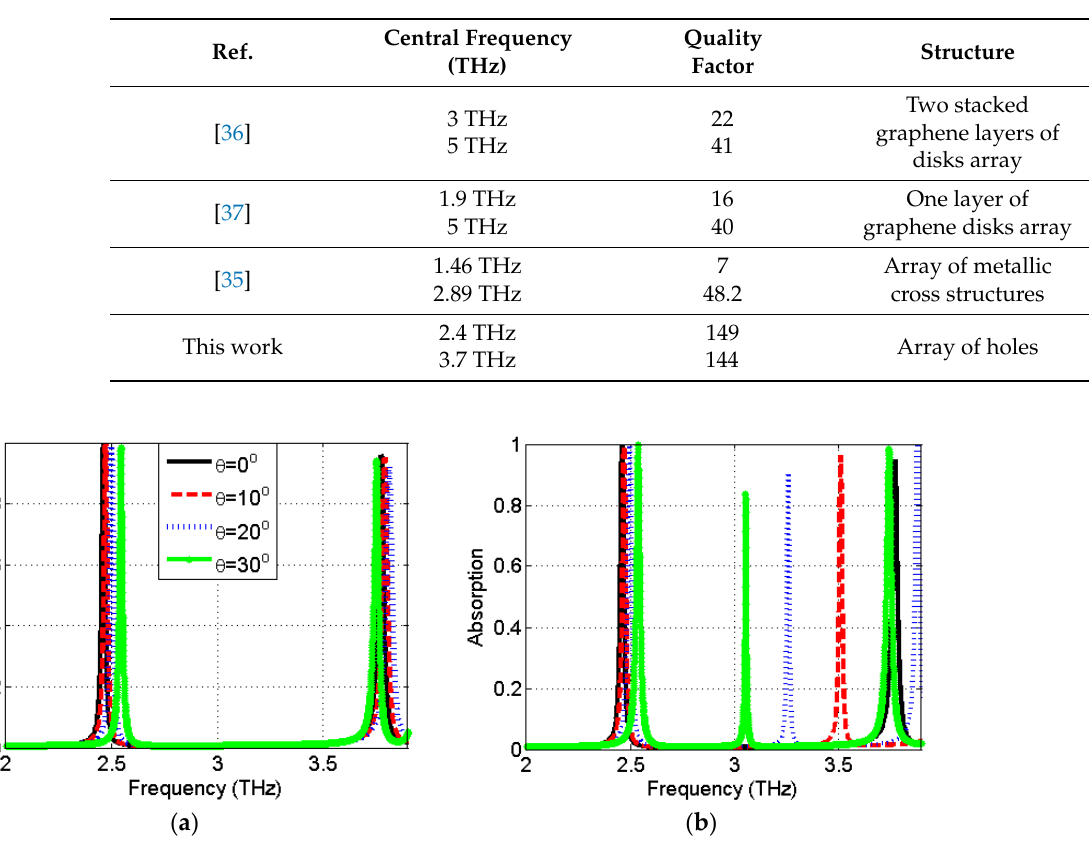
Table 1. Comparison of the proposed narrowband absorber with other reported THz narrowband absorbers.